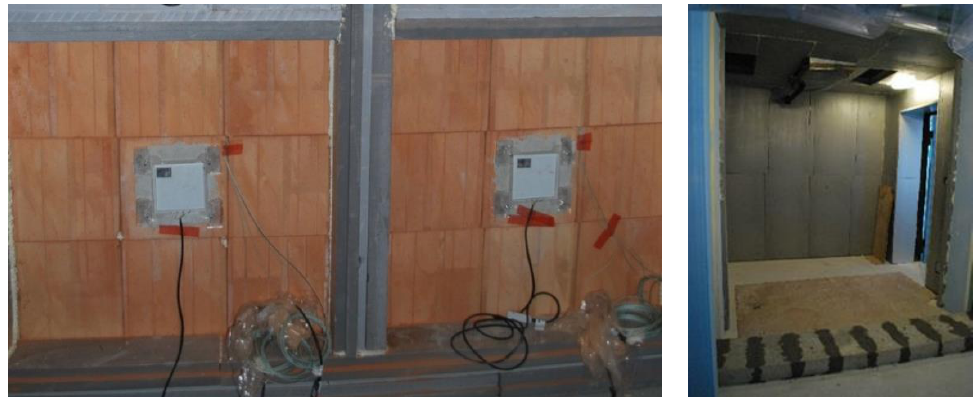
Figure 2. View of the partitions made of modified ceramic elements and the interior of the cold chamber—the preparatory stage.